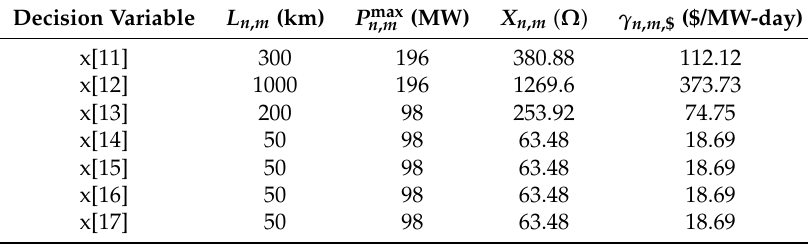
Table 3. Characteristics of the transmission lines